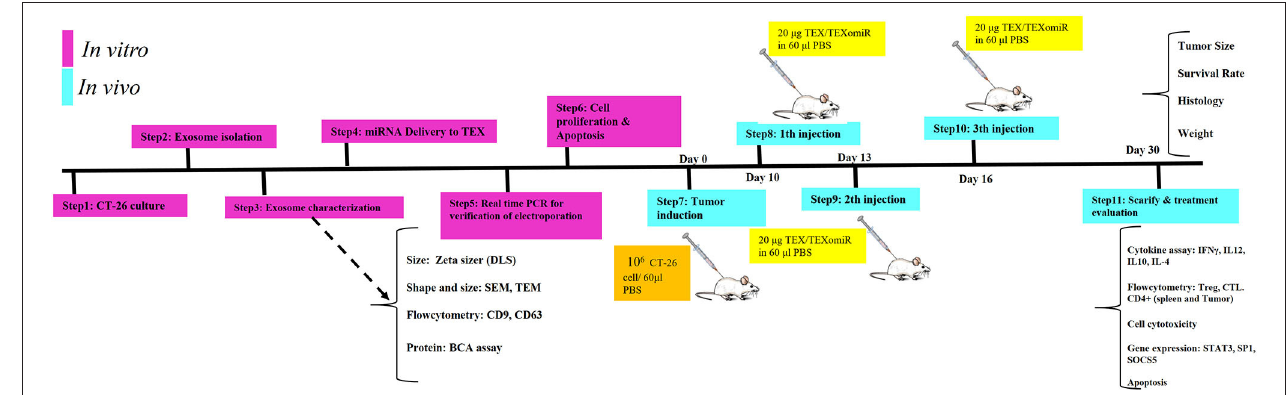
FIGURE 1 | Schematic illustration of the study design. In vitro and in vivo assay for the evaluation of anti-tumor effects of miR-124-enriched tumor